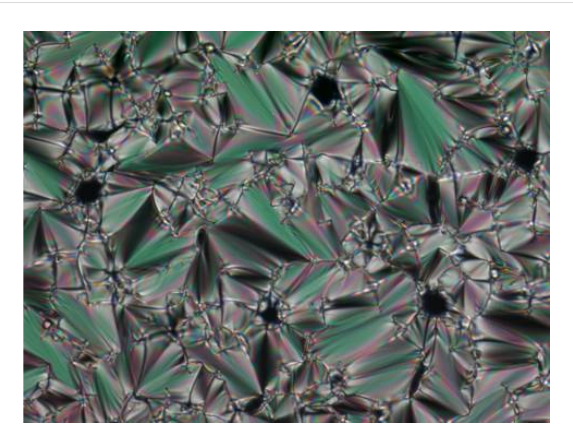
Figure 2: Fan-shaped texture of 3e under crossed polarizers upon cooling from the isotropic liquid (magnification 200×): at 55 °C (cooling rate 5 K/min): smectic A